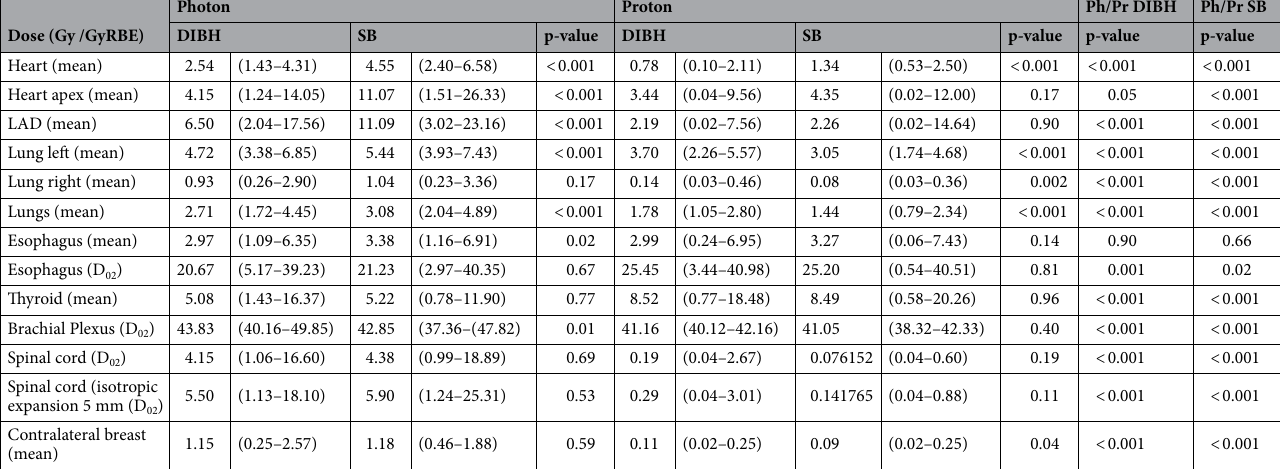
Table 1. Dose indices of organs-at-risk. Average values (range) for 31 patients. P-values for paired t-test. Column 6: p-values for photon DIBH versus photon SB plans. Column 11: p-values for proton DIBH versus proton SB plans. Column 12: p-values for DIBH photon versus DIBH proton plans. Column 13: p-values for SB photon versus SB proton